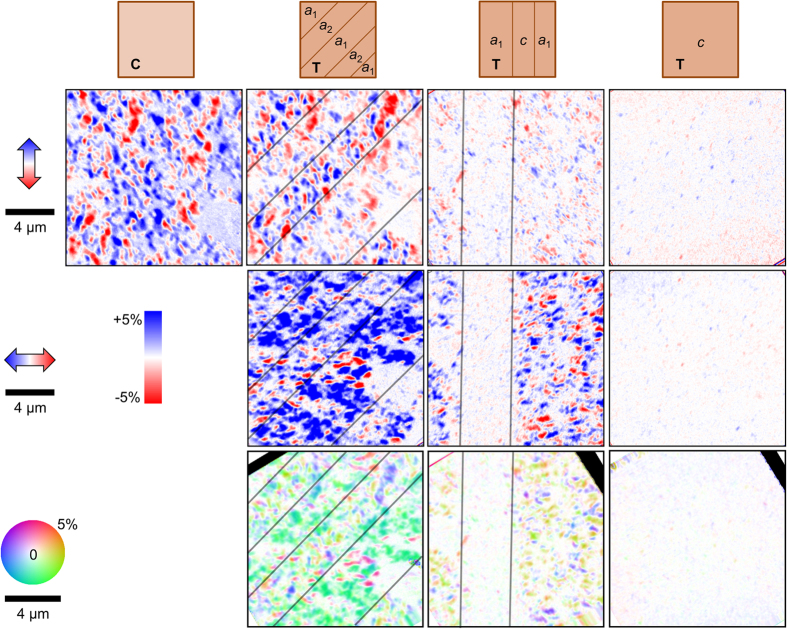
XMCD on various BTO domain arrangements.From top to bottom: sketches of expected BTO domains with reference to Fig. 1(b); corresponding Fe-XMCD images at azimuthal angle 0° with incident X-rays along page vertical; Fe-XMCD images at azimuthal angle 90° with incident x-rays along page horizontal; in-plane XMCD vector maps. Black lines mark inferred ferroelastic domain wall locations. Double-headed red-white-blue arrows indicate the component of magnetization that is measured in each row.